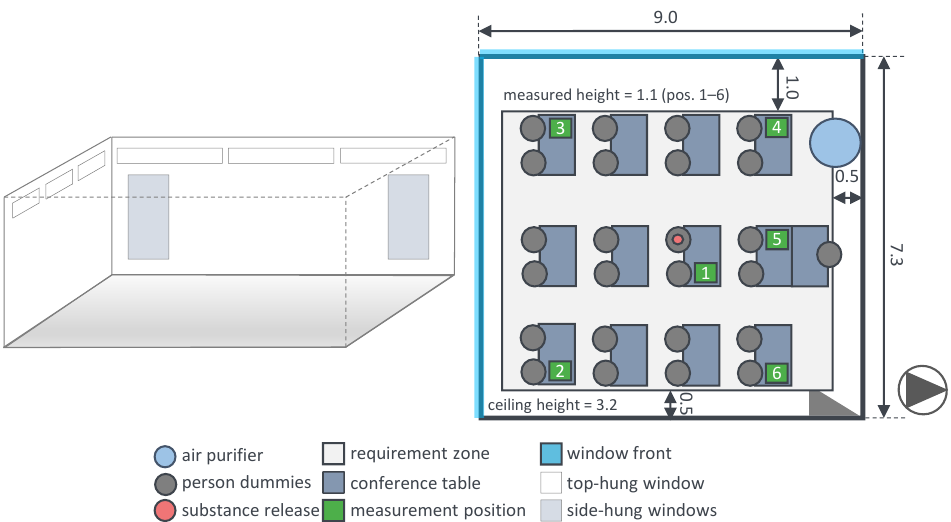
Figure 7. Draft ( left ) and the top view ( right ) of the experimental set up of a classroom with an air purifier.